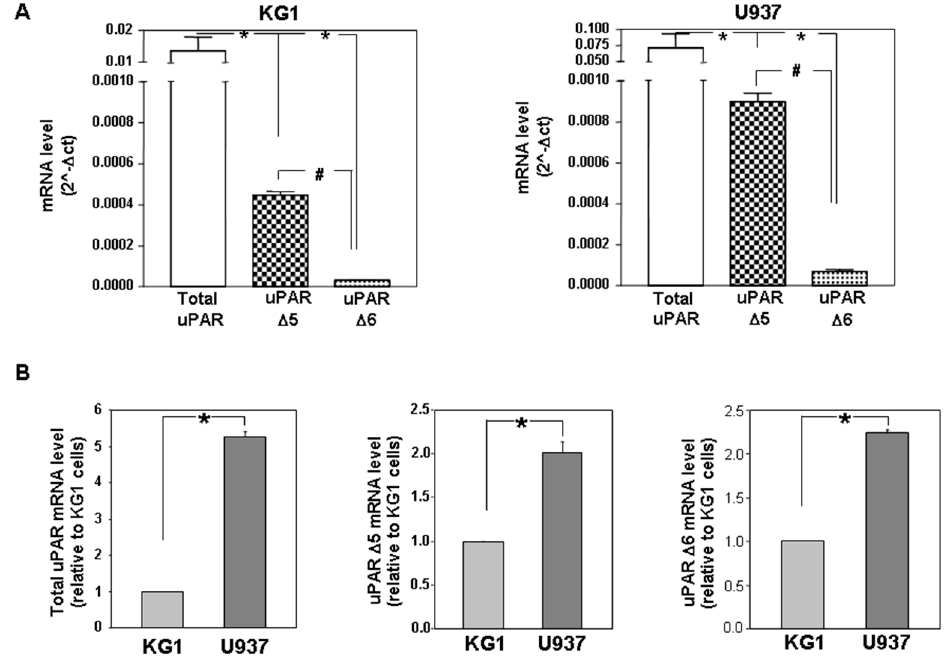
Figure 2. AML cell lines express different amounts of uPAR variants. ( A ) The levels of uPAR, uPAR Δ 5 and uPAR Δ 6 transcripts, normalized to the internal glyceraldeyde-3-phosphate dehydrogenase (GAPDH) mRNA, were analysed by qRT-PCR in KG1 (left panel) and in U937 (right panel) cells. The absolute level of expression was calculated with the formula 2 −Δ CT . Values are the mean ± SEM of three experiments performed in triplicate; * p < 0.05 as determined by the Student’s t test, total uPAR vs each variant; # p < 0.05 as determined by the Student’s t test, uPAR Δ 5 vs uPAR Δ 6. ( B ) The levels of uPAR, uPAR Δ 5 and uPAR Δ 6 transcripts were analysed by qRT-PCR and expressed as fold change of uPAR expression in U937 cells relative to KG1 cells. The relative level of expression was calculated with the formula 2 −ΔΔ CT . Values are the mean ± SEM of three experiments performed in triplicate; * p < 0.05 as determined by the Student’s t test.